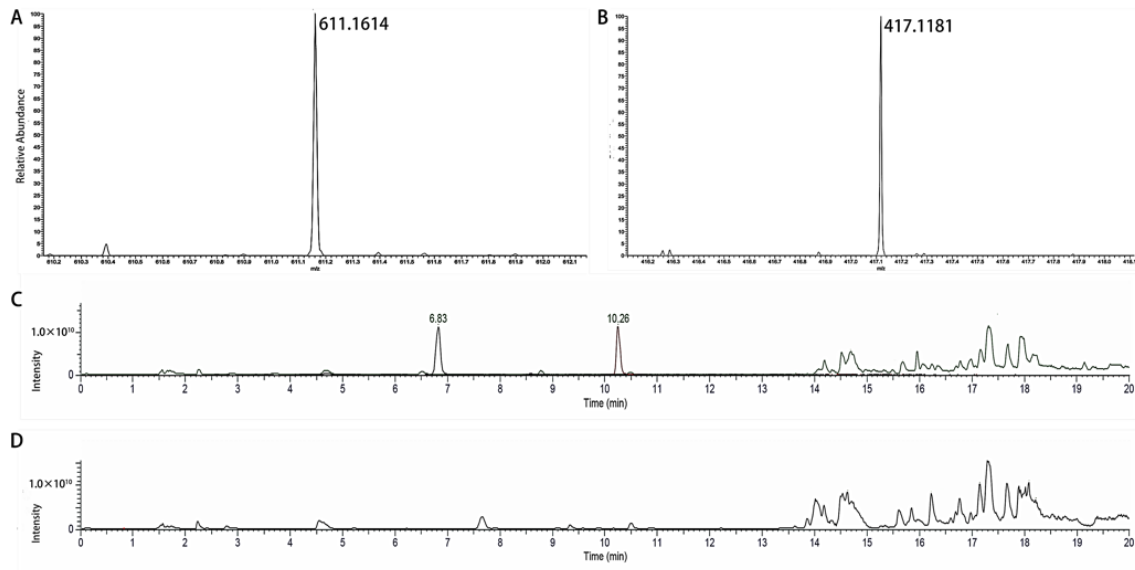
Figure 4. Mass spectra of IS ( A ) and PUE ( B ); Total ion chromatogram of plasma spiked with PUE and IS ( C ); Total ion chromatogram of blank plasma ( D ).